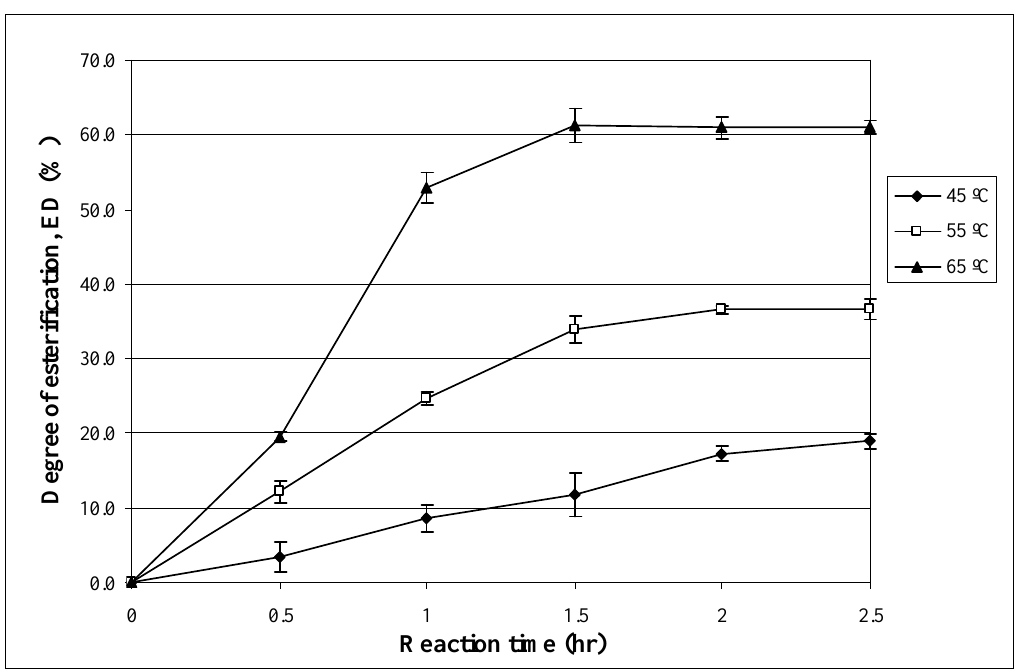
FIGURE 3. Effect of temperature on the performance of intensified esterification in a PBR. The reaction mixture consists of 2.0 kg PFAD, 0.336 kg glycerol (at a molar ratio of 2.0), and 4.0 kg hexane. The reaction water was removed by the silica gel (1 kg) filled in the water-removal vessel. The PBR was filled with 10 kg of immobilized RBL. Samples were tested in triplicate.